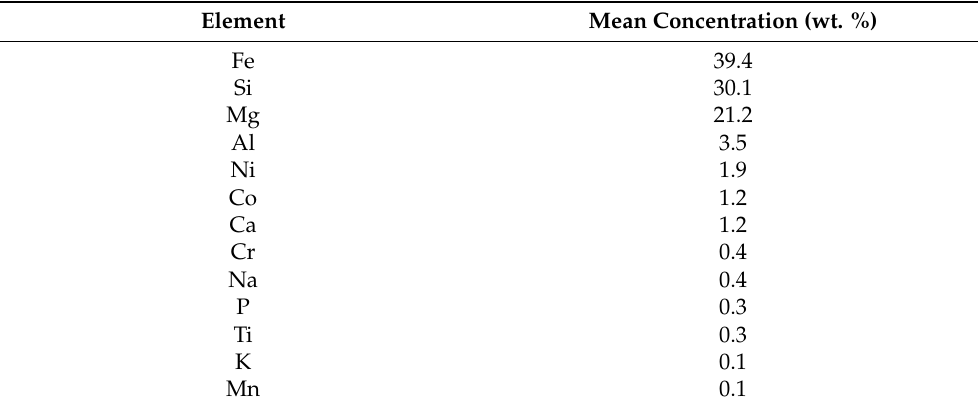
Table 4. Mean elemental composition of NWA 1990 stony meteorite excluding oxygen. The error in the values is